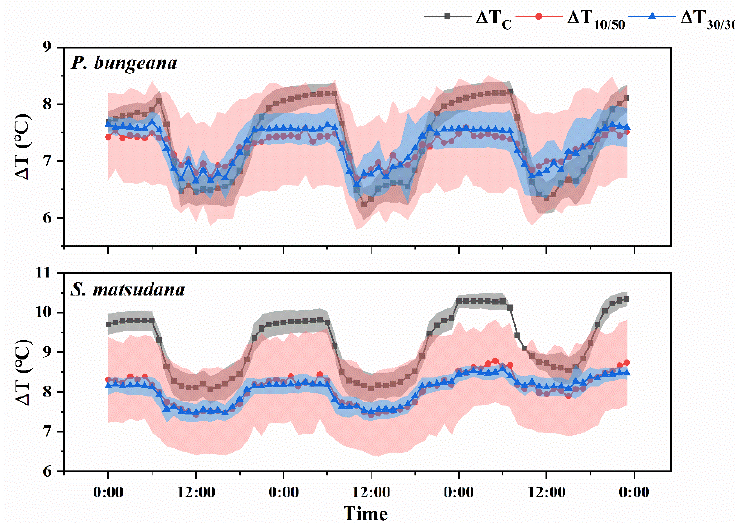
Figure 2. Diurnal variation of temperature difference under continuous heating (T C , black), 10 min heating and 50 min cooling (T 10/50 , red), and 30 min heating and 30 min cooling (T 30/30 , blue). Dots and shade represent mean values and standard deviations, respectively, calculated from three trees.